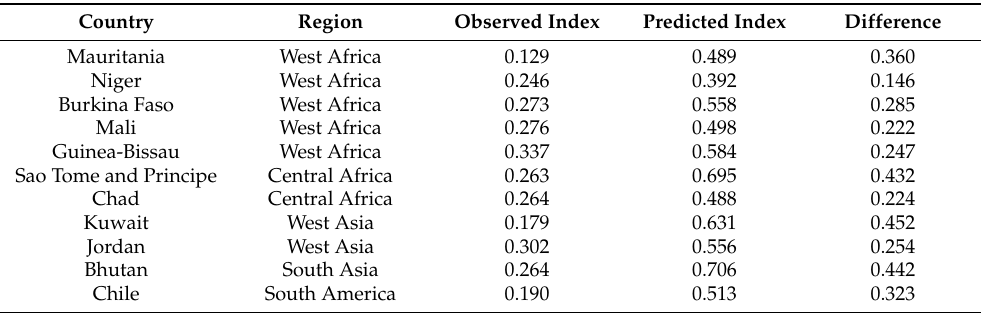
Table 4. Eleven countries with the smallest observed index. For the observed index and predicted index, 0 means that the number of species is zero, and 1 means the highest possible value of the number of species (all known ant species are found in that country). Country Region Observed Index Predicted Index Difference Mauritania West Africa 0.129 0.489 0.360 Niger West Africa 0.246 0.392 0.146 Burkina Faso West Africa 0.273 0.558 0.285 Mali West Africa 0.276 0.498 0.222 Guinea-Bissau West Africa 0.337 0.584 0.247 Sao Tome and Principe Central Africa 0.263 0.695 0.432 Chad Central Africa 0.264 0.488 0.224 Kuwait West Asia 0.179 0.631 0.452 Jordan West Asia 0.302 0.556 0.254 Bhutan South Asia 0.264 0.706 0.442 Chile South America 0.190 0.513